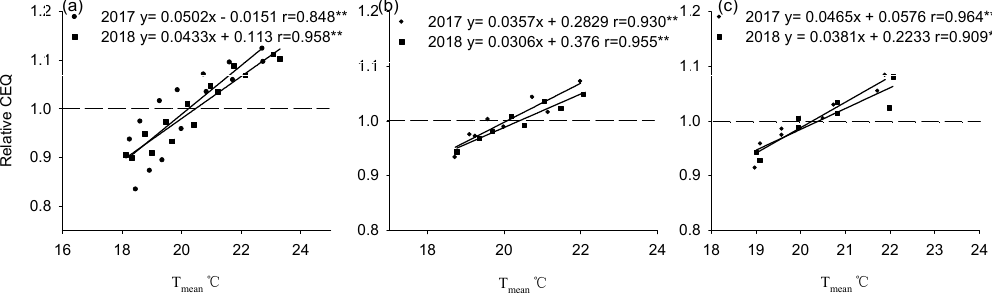
Figure 9. Correlation between relative CEQ and Tmean at the stage from heading to maturity. ( a ): SMR, n = 14, ( b ): SLR n = 8, ( c ): LR, n = 8. **, p < 0.01, respectively. Table 8. Characteristics of temperature in the grain filling stage for good eating quality rice ( ◦ other years, which have been analyzed in detail in a separate paper [31]. This indicates